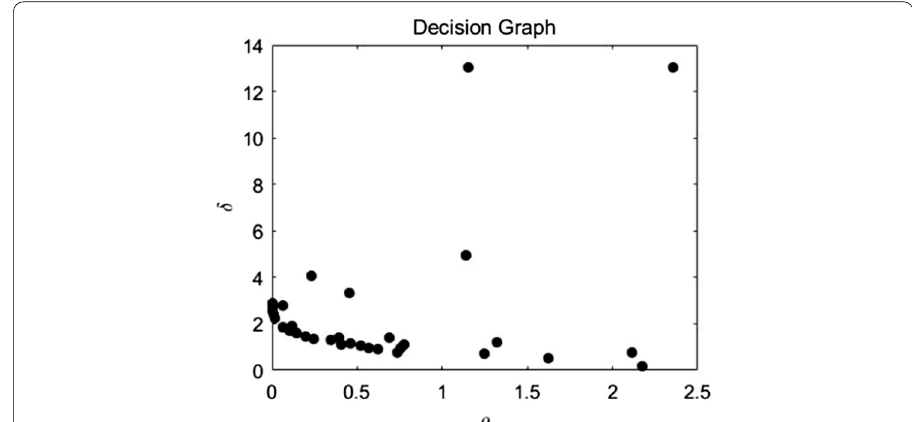
Fig. 2 The decision map which includes 34 switch point. x axis: ρ : This symbol represents the local density of switch nodes, which means the size of the number of data points in a certain area. y axis: δ : This symbol represents the relative distance of switch nodes, but the calculation of this value can be divided into two cases. Case 1: for the switch node with the highest density, because of there is no switch node with higher density, its relative distance is defined as the maximum distance between the switch node and all other switch nodes. Case 2: for other switch nodes, the relative distance is defined as the shortest distance between the switch node and other switch nodes with higher local